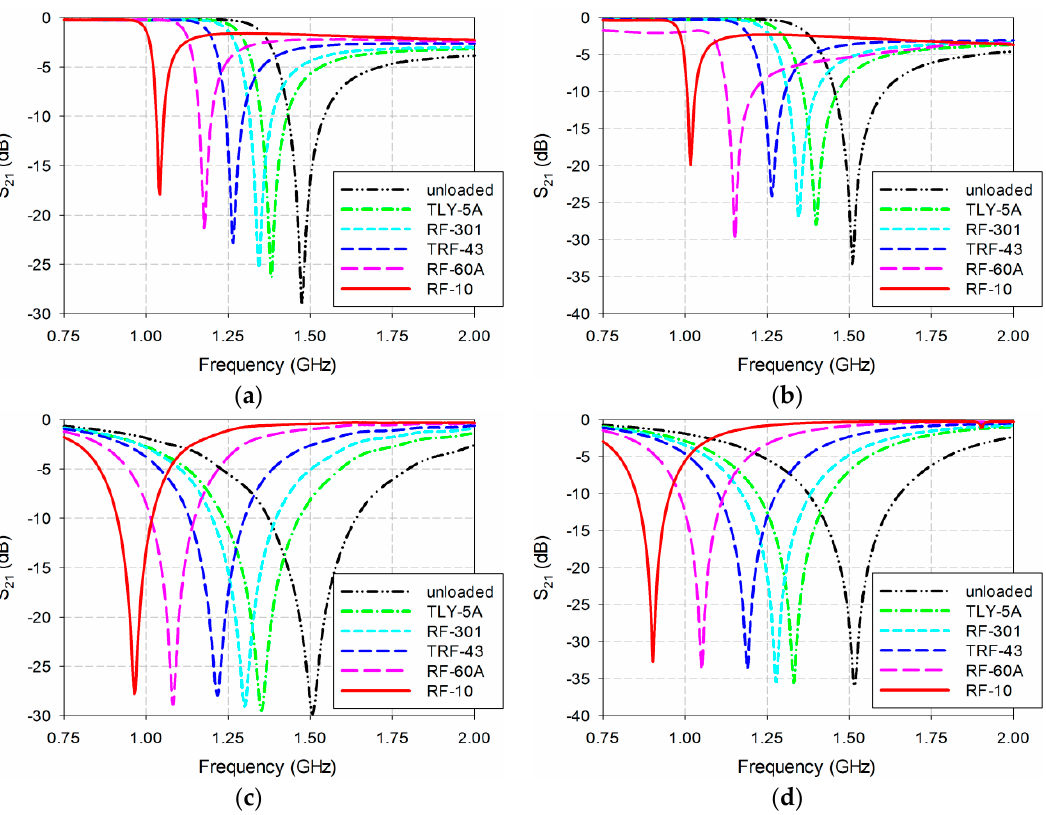
Figure 12. Measured S 21 characteristics of the four permittivity sensors for MUTs in Table 2: ( a ) DR-CSRR; ( b ) SR-CSRR; ( c ) R-SR-CSRR; ( d ) proposed IDCS-DGS.